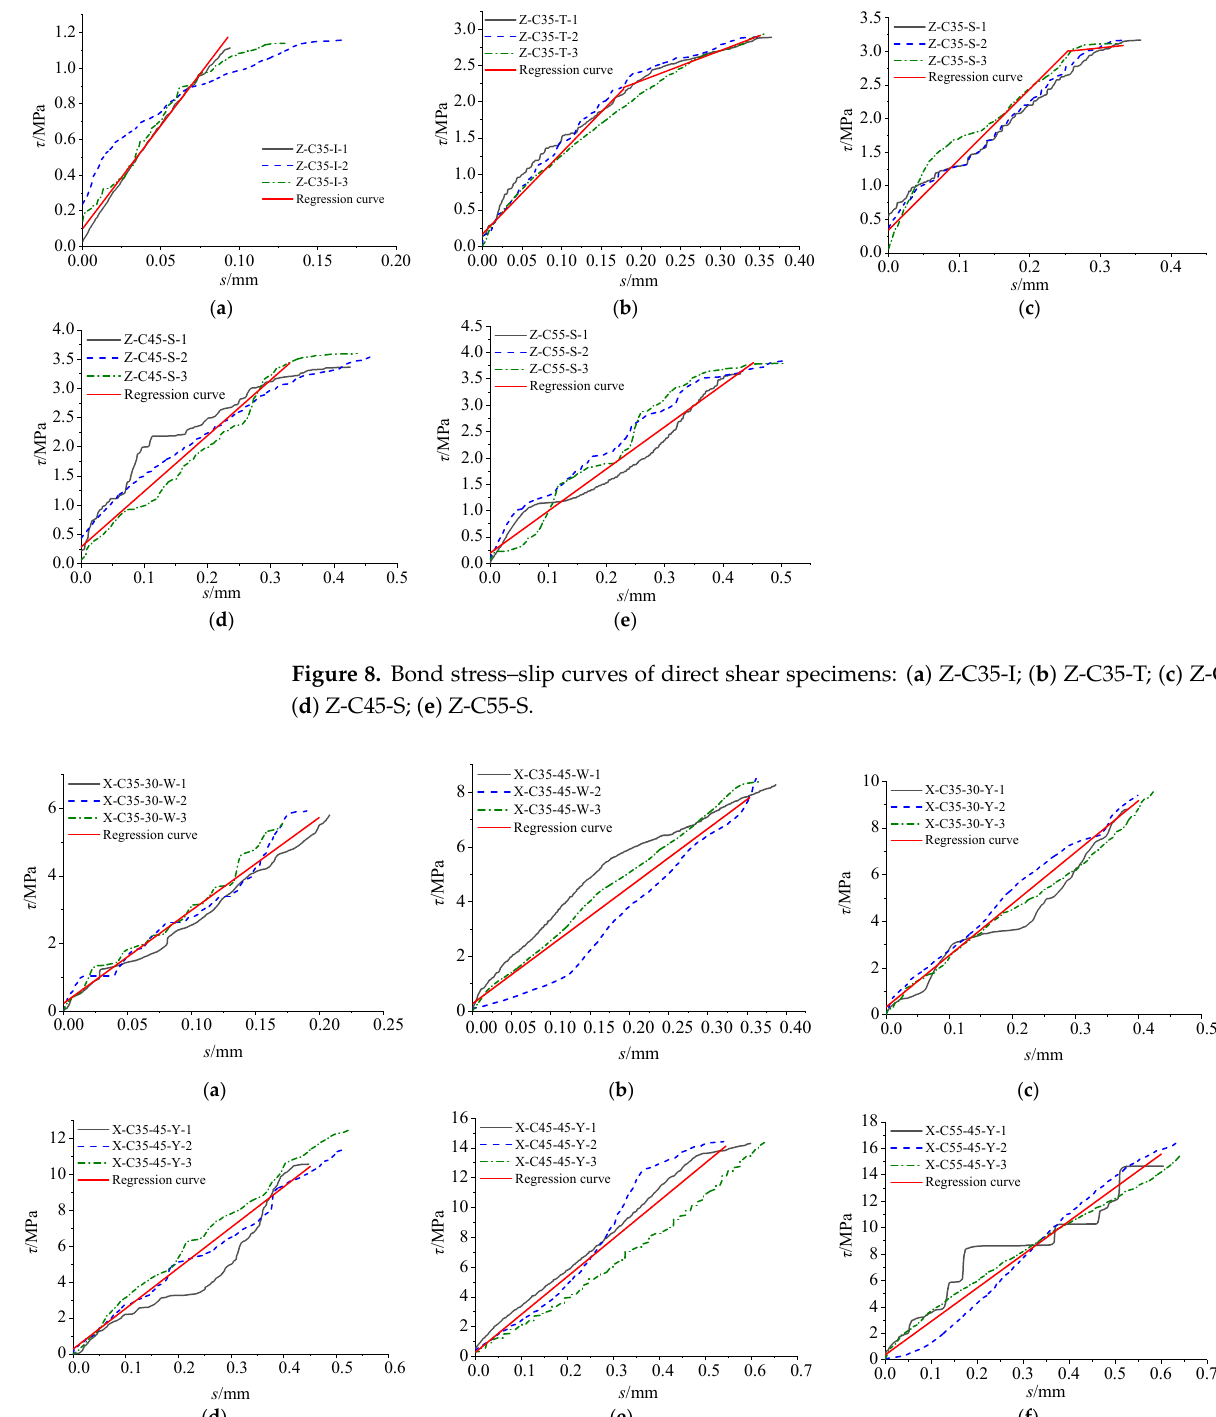
Table 6. Parameters related to the interface bond–slip curves.